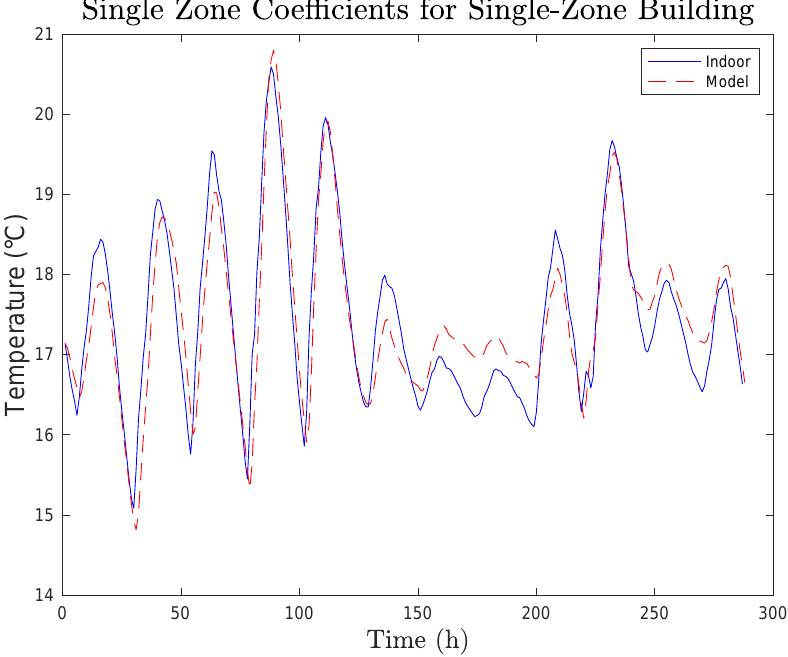
Figure 5. Single zone coefficients fit to a single zone building using the second order model.